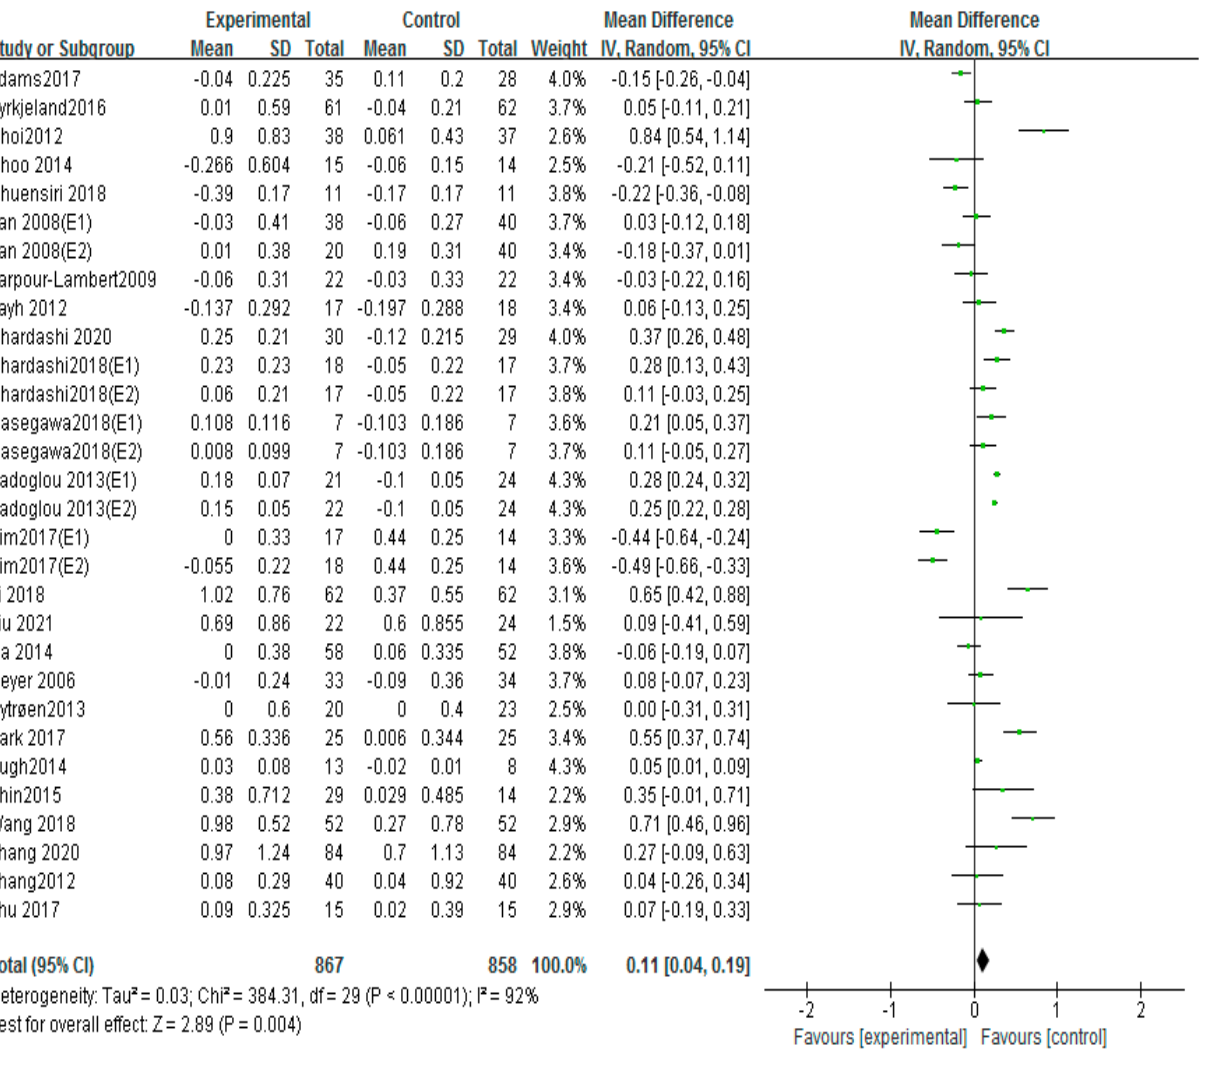
Figure 10. Meta − analyses of the effect of exercise on HDL − C compared with the control group